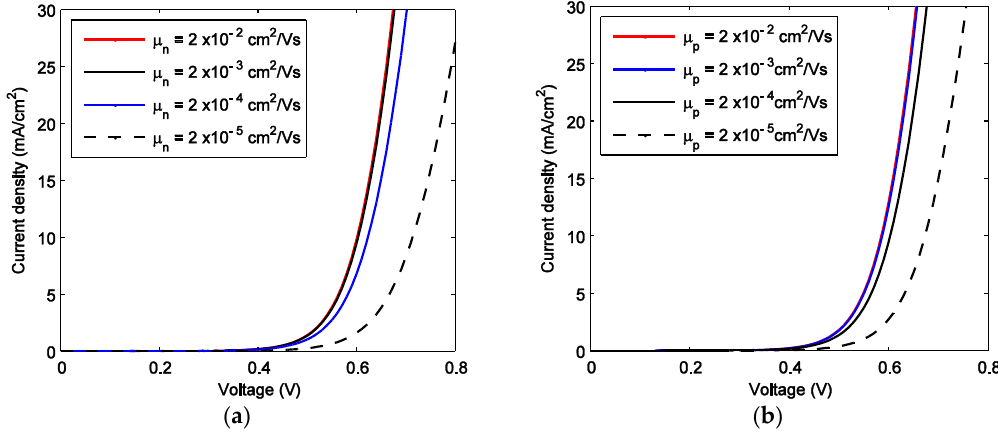
Figure 4. Theoretical dark current-voltage characteristics of P3HT:PC 61 BM solar cells for ( a ) varying n with p = 2 10 −4 cm 2 /Vs and ( b ) varying p with n = 2 10 −3 cm 2 /Vs.